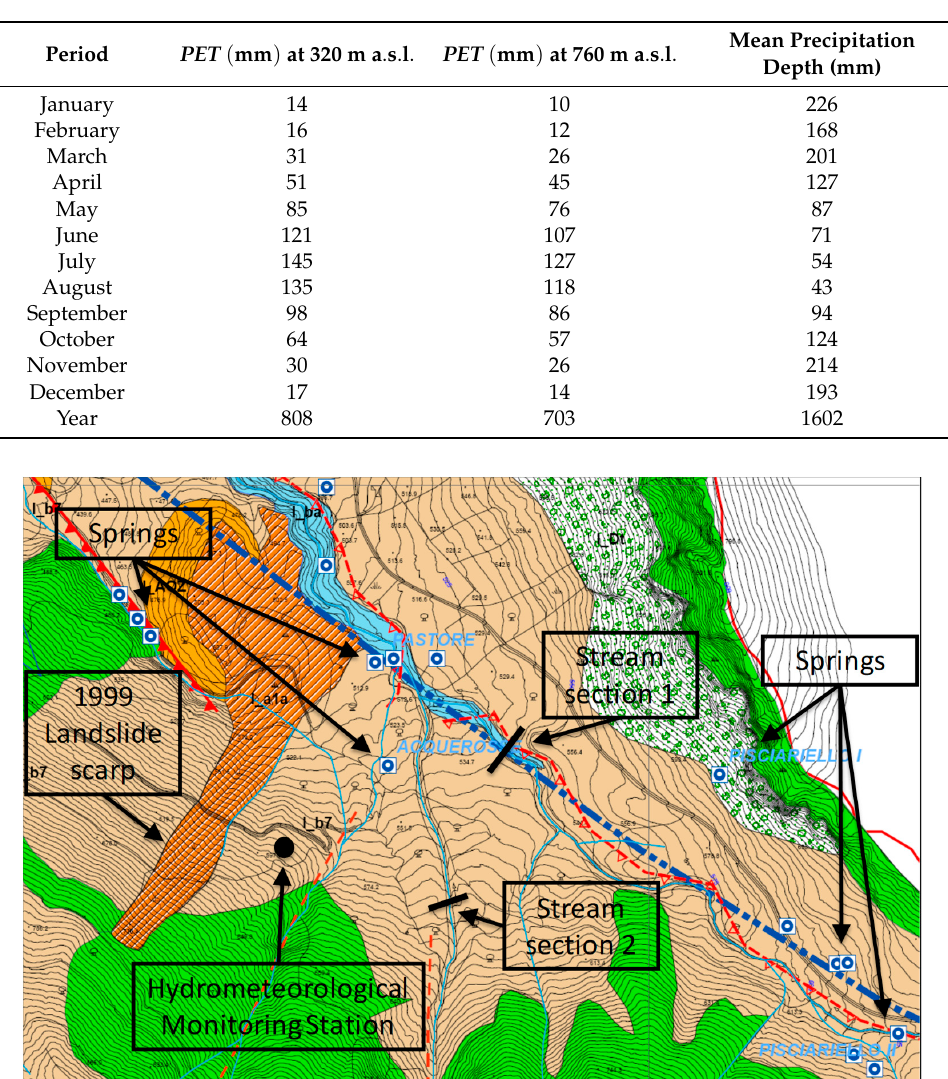
Table 2. Mean potential evapotranspiration ( PET (L)), calculated with the empirical formula of Thornthwaite, and precipitation depth (L), based on meteorological data measured at Cervinara between 2001 and 2017.